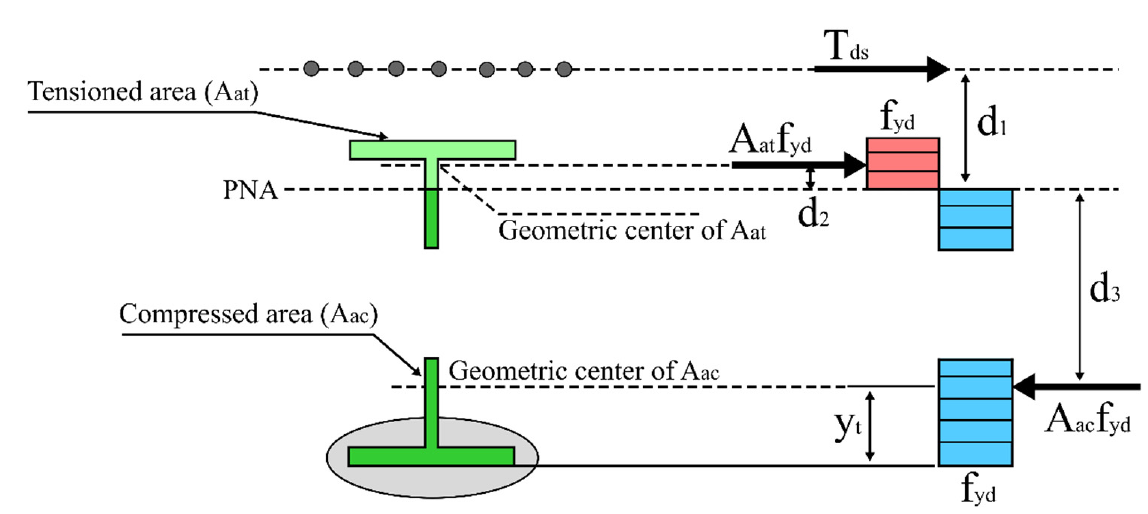
The parameters are A f , which is the flange area, and T ds , which is the calculation tensile strength of the reinforment bars ( A bar * f y , bar ).